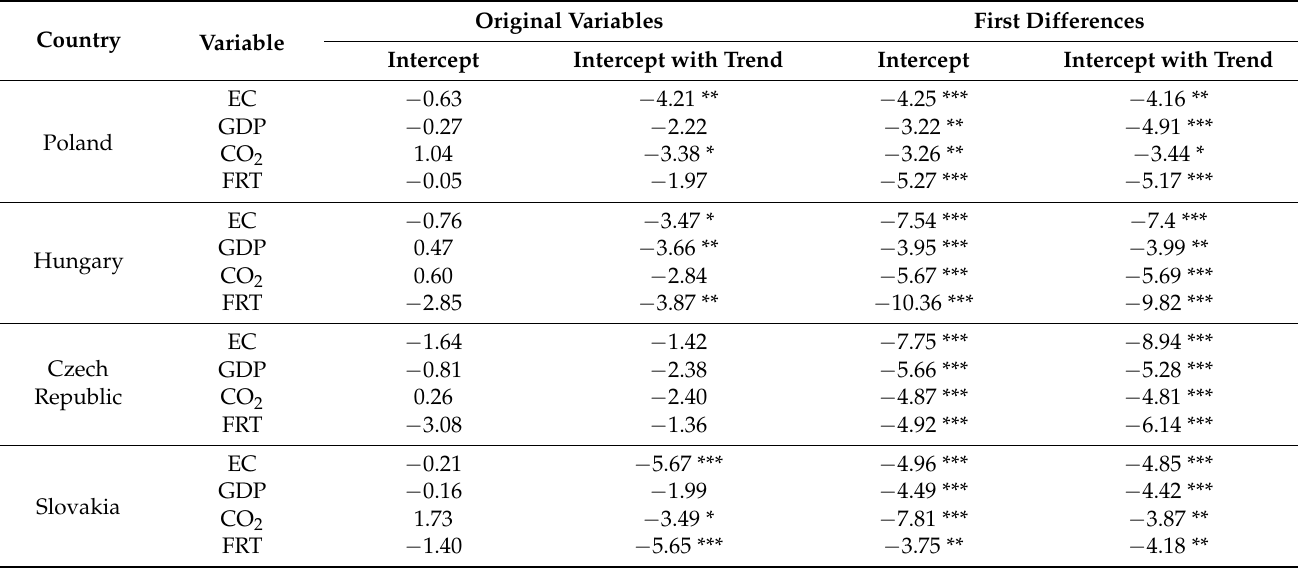
Table 3. Unit root test results (the augmented Dickey–Fuller test